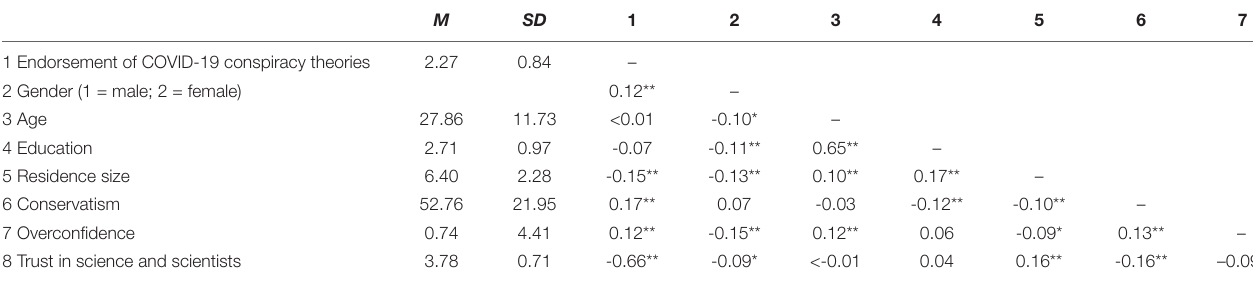
TABLE 1 | Correlation matrix and descriptive statistics for all the variables in the model.